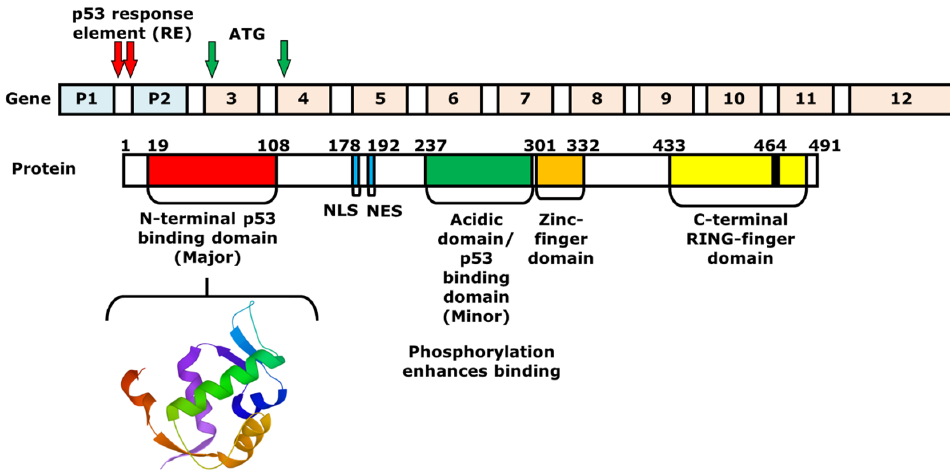
Figure 2. Structures of the MDM2 gene and protein. The 3D structure of a portion of MDM2 protein (17–111) is shown below, which consists of the N-terminal p53-binding domain (19–108). The MDM2 gene consists of two promoters and 10 additional exons. Between exons 1 and 2, or the first